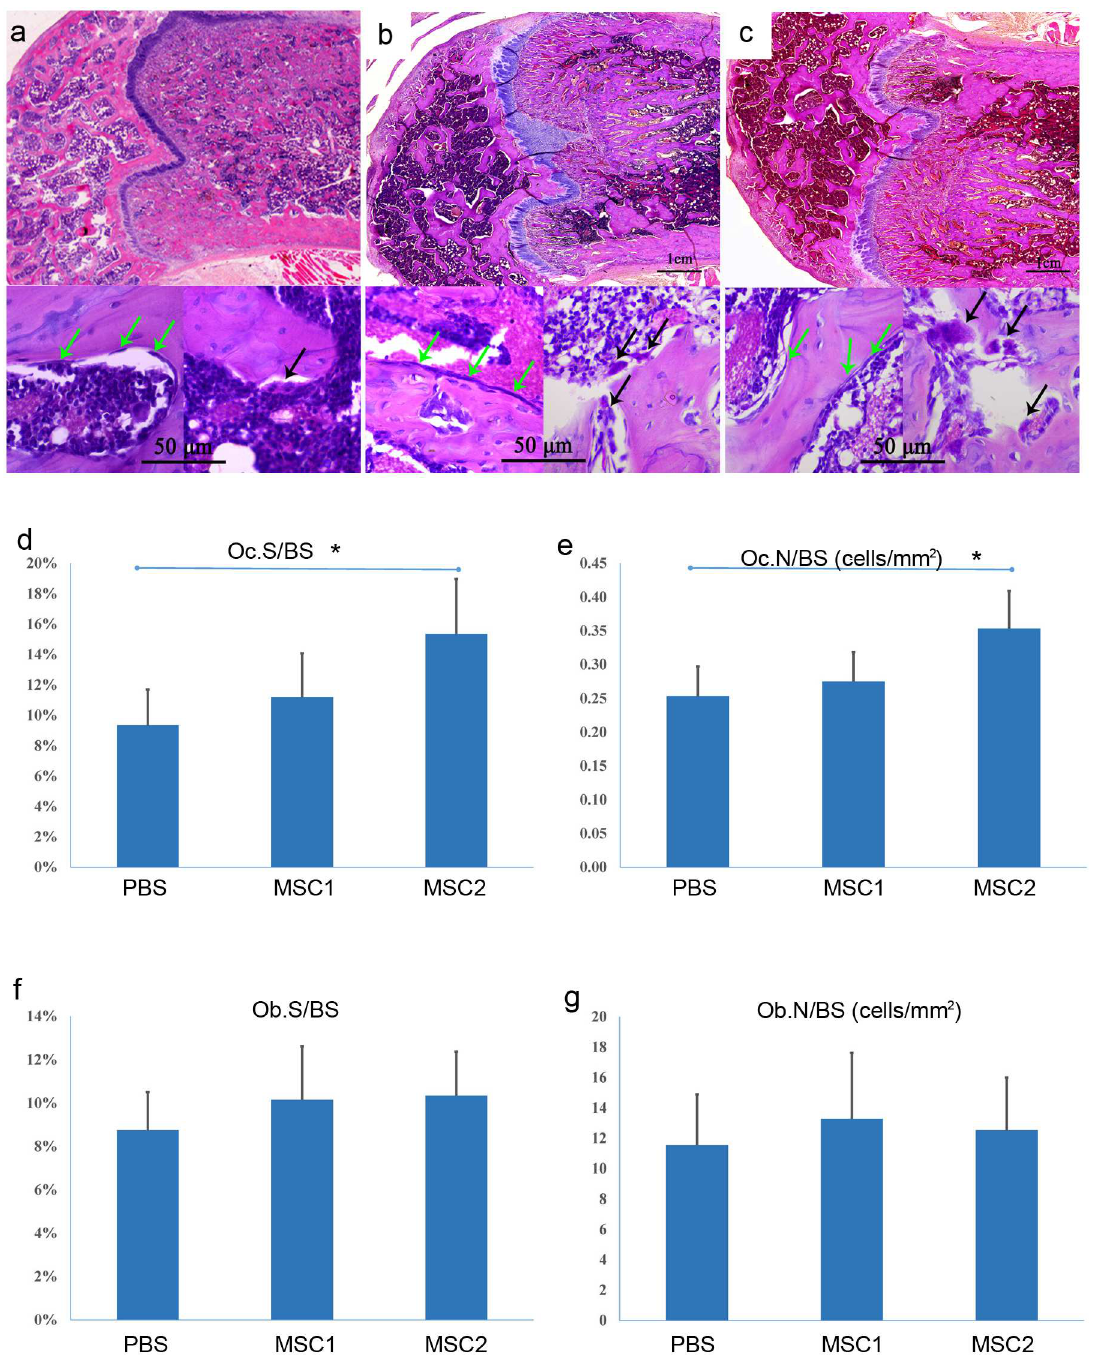
Fig 5. Bone histomorphometric analysis of the trabecular bones. H&E staining showed that trabecular bone had no obvious morphological differenceamong the PBS group (a), MSC group 1 (b) and MSC group 2 (c). Photomicrographs with higher magnification ( × 400) were attached on the bottom. Osteoblasts (green arrows) and osteoclasts (black arrows) were all observed in all three groups. (d&e) Quantitative analysisof the Oc.S/BS and Oc.N/BS in the three groups. Data was presented as mean ± SD (n = 8). Significant level was taken at p < 0.05. (f&g) Quantitative analysisof the Ob.S/BS and Ob.N/ BS in the three groups. Data was presented as mean ± SD (n = 8). Significant level was taken at p <